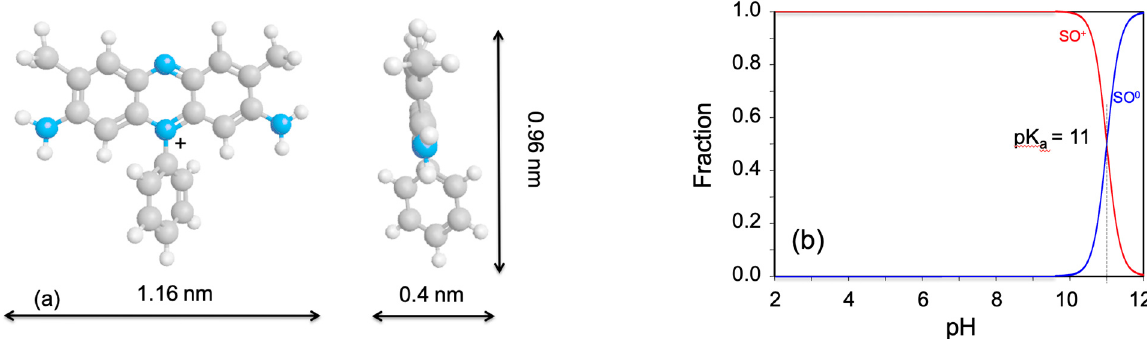
Figure 2. Molecular structure of SO viewed from different directions ( a ) and its pH-speciation ( b ).